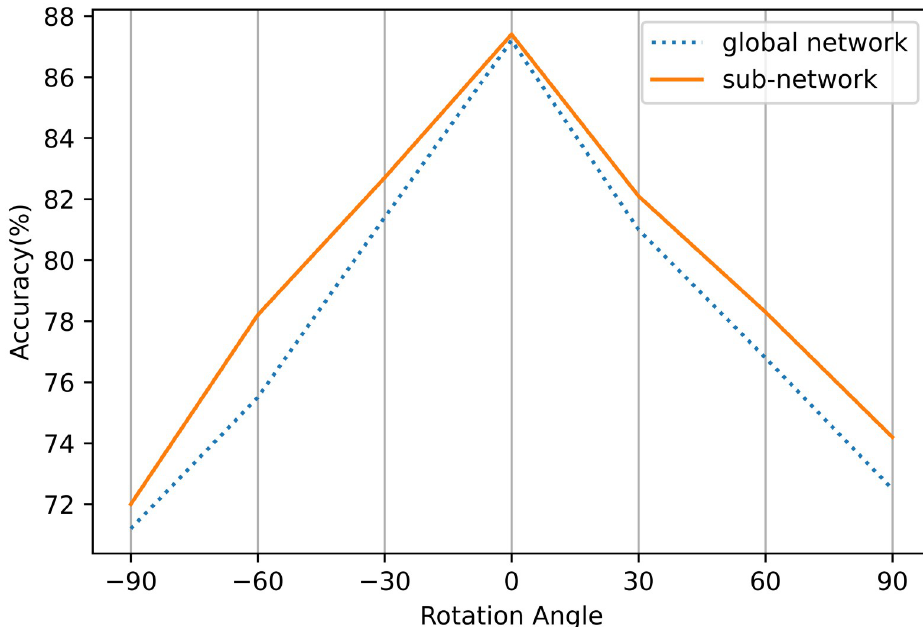
Fig 3. Recognition results on our synth dataset with different rotation